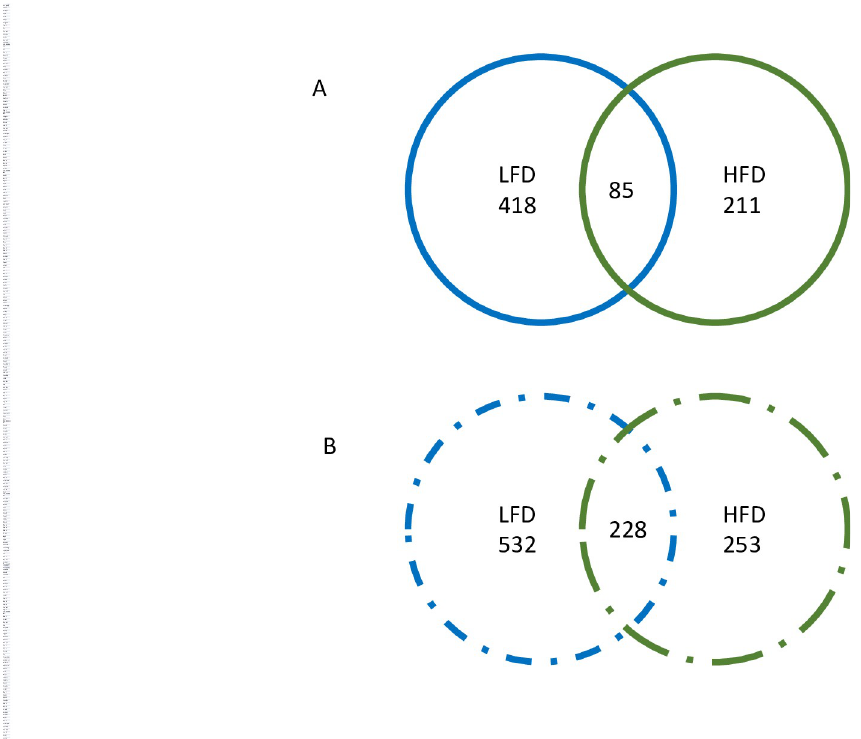
Fig 5. Venn diagrams depicting A) shared and exclusively upregulated genes in TMG compared to IMG and B) shared and exclusively downregulated genes in TMG compared to IMG .